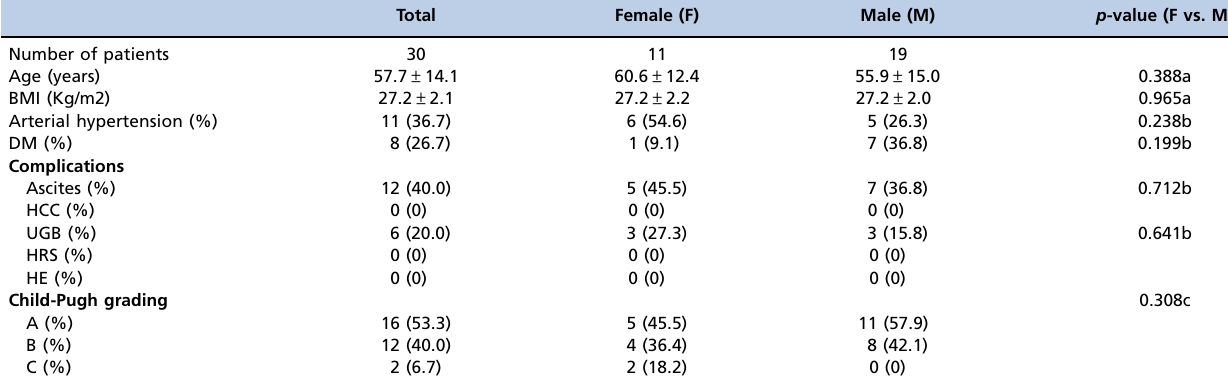
Table 3 - Clinical characteristics of NASH-related